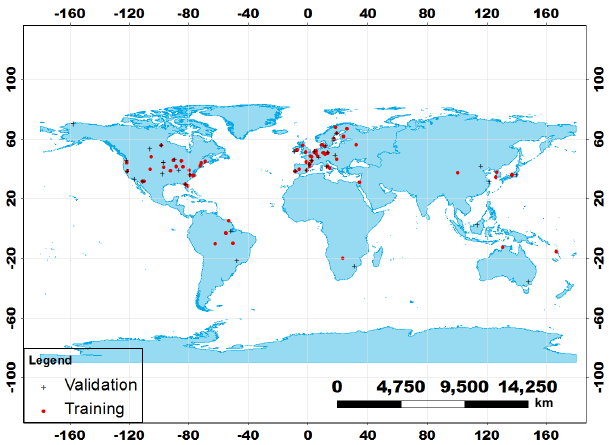
Figure 3. Distribution of 126 sites of the FLUXNET eddy covari- ance network used in the present study with 85 and 41 sites for training and validation between the years 1999 and 2006, respec-